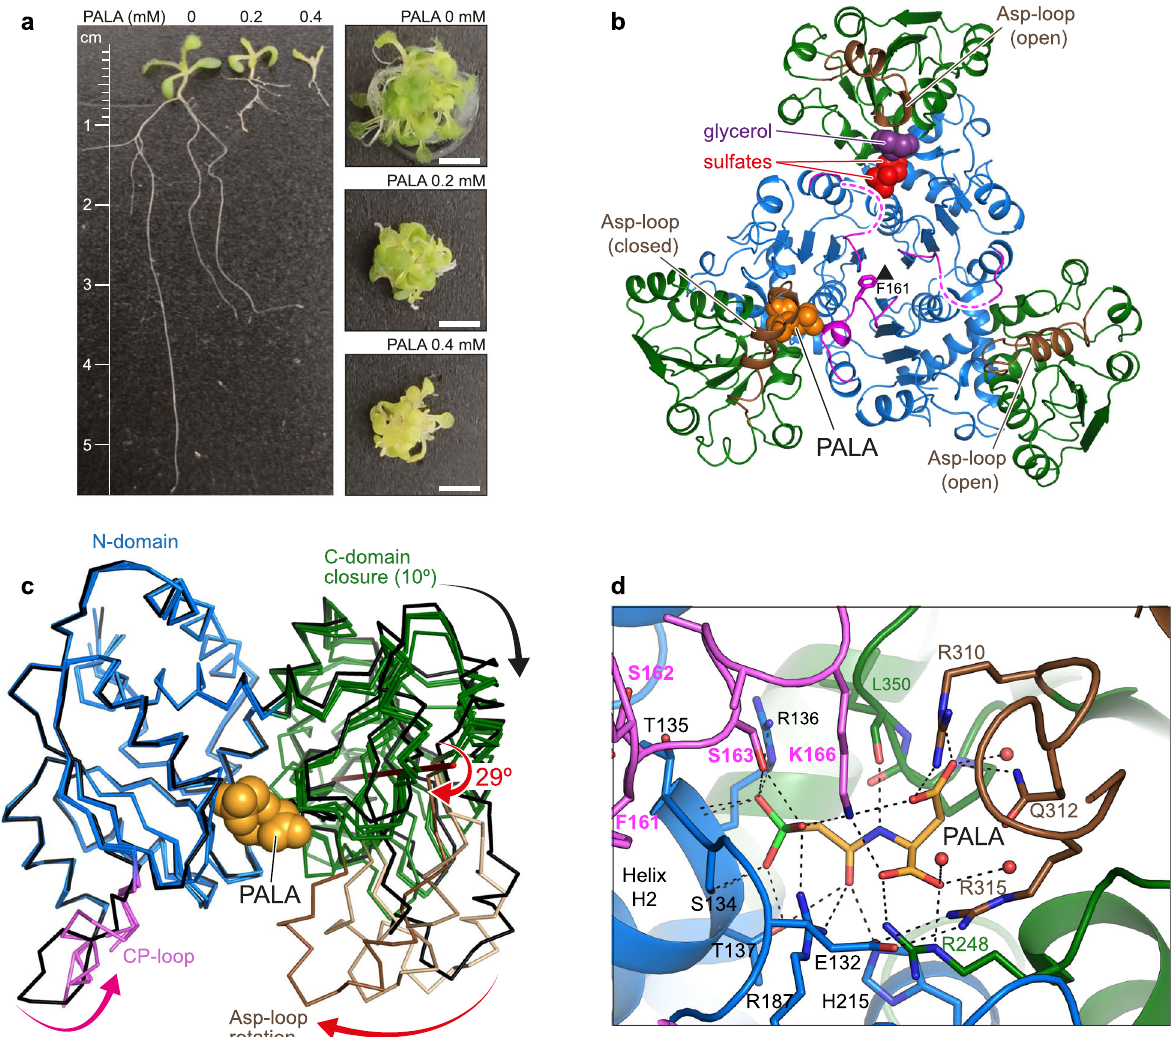
Fig. 3 Inhibition of atATC by the transition-state analog PALA. a Inhibition of Arabidopsis seedlings after 7 days treatment with PALA. Images are typical examples of 30 seedlings viewed per treatment. Scale bars indicate 0.5 cm. b Crystal structure of atATC trimer in complex with only one molecule of PALA (shown as orange spheres). Dashed lines indicate fl exibly disordered CP-loops. c Superposition of the three subunits in the PALA-bound trimer (colored as in b ) and in the UMP-bound subunit (in black). The arrows indicate the closure of the subunit upon PALA binding. The Asp-loop undergoes a 29° rotation around an axis that has been represented and colored in red. d Detail of the binding of PALA to the active site. Water molecules are shown as red spheres. Electrostatic interactions are indicated as dashed